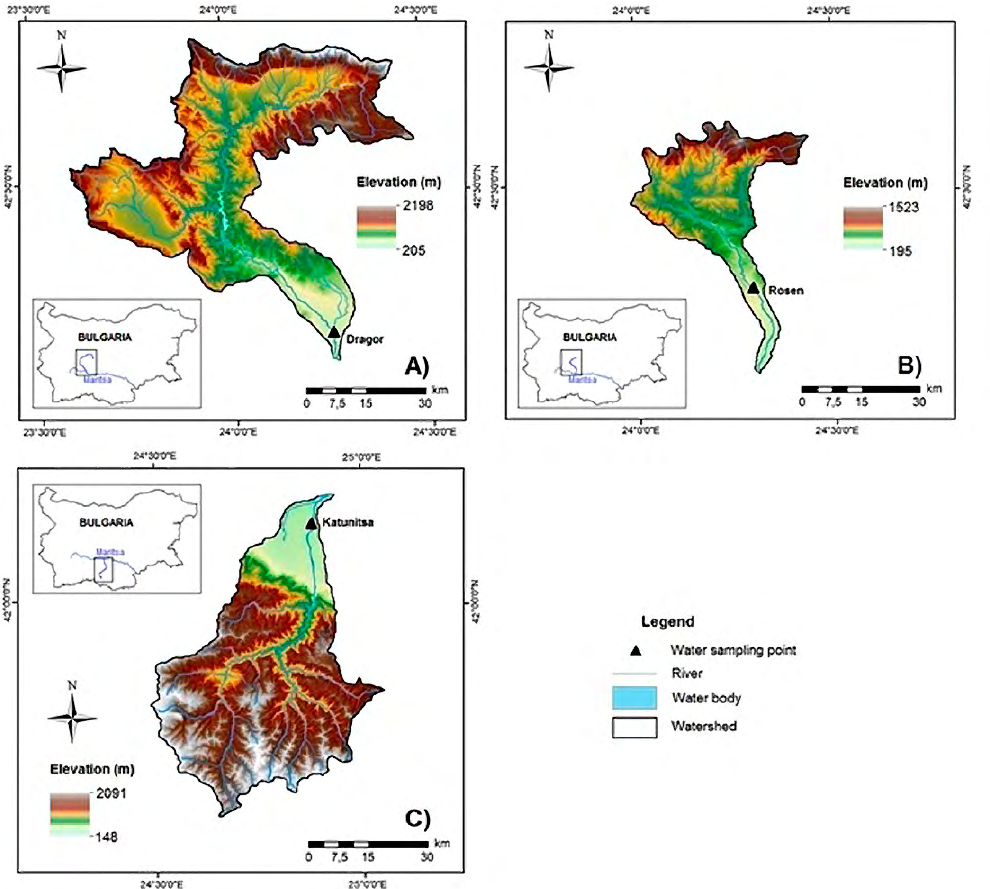
Figure 1. Maps of the relief and the drainage network showing the location of water sampling points: A) Topolnitsa River basin; B) Luda Yana River basin; C) Chepelarska River